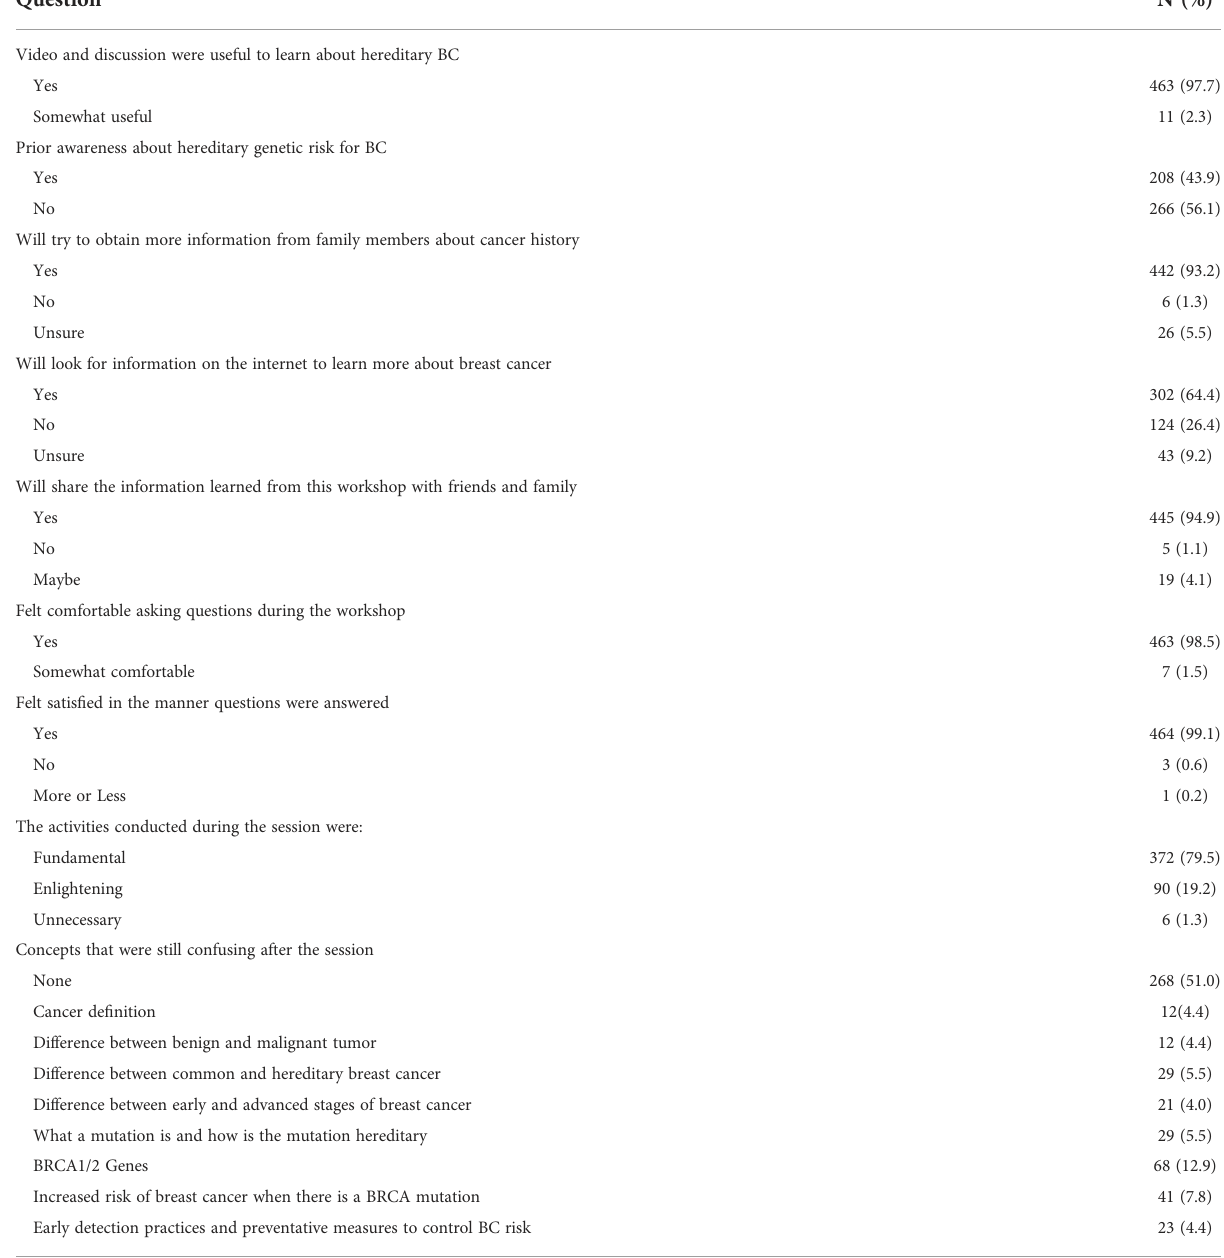
TABLE 9 ‘ Tu Historia Cuenta ’ education session feedback survey responses